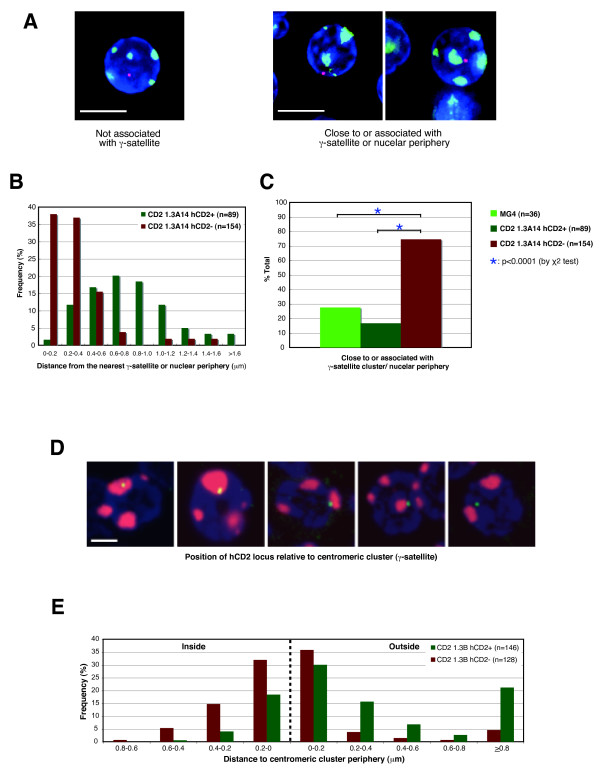
Nuclear localization of the hCD2 transgene in hCD2+ and hCD2- T cells. (A, B, C) Three-dimensional fluorescence in in situ hybridization (FISH) analysis of the hCD2 transgene location in the nuclei of CD2 1.3A14 and MG4 transgenic T cells. (A) Deconvoluted images showing typical examples of two nuclear localization patterns of the hCD2 transgene (red) relative to γ-satellite clusters (green) and to the nuclear periphery (determined by DAPI-staining, blue). Bar: 5 μm. (B) The distance between the hCD2 transgene signal and the nearest γ-satellite clusters or nuclear periphery in CD2 1.3A14 hCD2+ and hCD2- T cells. The distance was measured from the centre of the transgene signal to the edge of a pericentric cluster or nuclear periphery. Median for hCD2+ T cells = 0.76 μm, that for hCD2- T cells = 0.29 μm. The difference in the distance of the transgene signal from heterochromatin between hCD2+ and hCD2- T cells was statistically significant: P < 0.0001 by K-S test. (C) The percentage of hCD2+ and hCD2- T cells from the indicated transgenic lines that show close proximity of the transgene signal to heterochromatic nuclear compartments. The difference in the transgene location between hCD2+ and hCD2- T cells was statistically significant (P < 0.0001 by χ2 test). Note that as expected the difference in the transgene location between Mg4 and CD2 1.3A14 hCD2+ T cells was not statistically significant (P > 0.05 by χ2 test). (D) The position of the hCD2 locus relative to the centromeric cluster was determined in sorted CD2+ and CD2- T cells, by cryoFISH using Rhodamine-labelled γ-satellite for detection of the centromeric cluster (red) and the DIG-labelled hCD2-cos1 cosmid probe to detect hCD2 loci (green). Nucleic acids were counterstained with TOTO-3 (blue). Bar: 2 μm. (E) The frequency of association of hCD2 locus with centromeric cluster were measured from the centre of the hCD2 signal to the periphery of the γ-satellite signal.